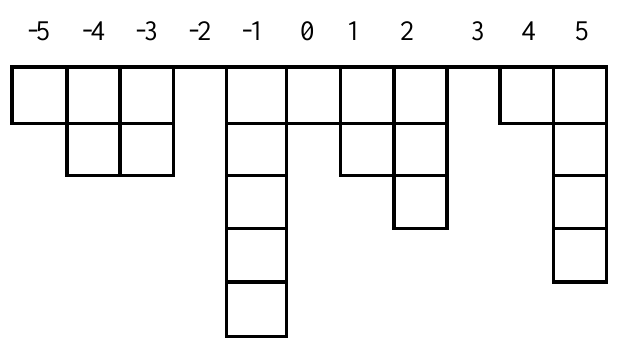
Table 3: Enterprise architecture